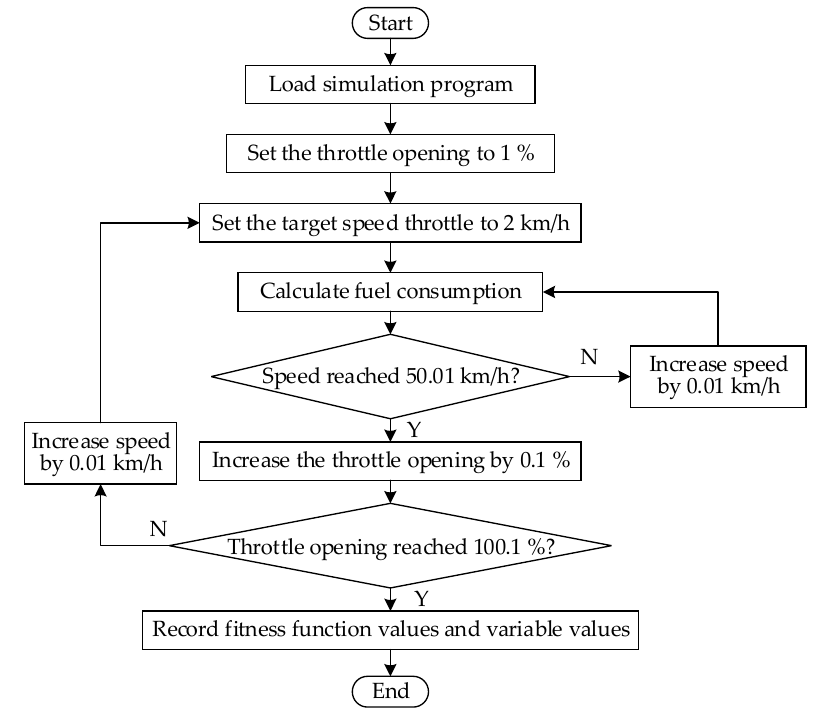
Figure 6. Flow chart of calculating the fitness function value.